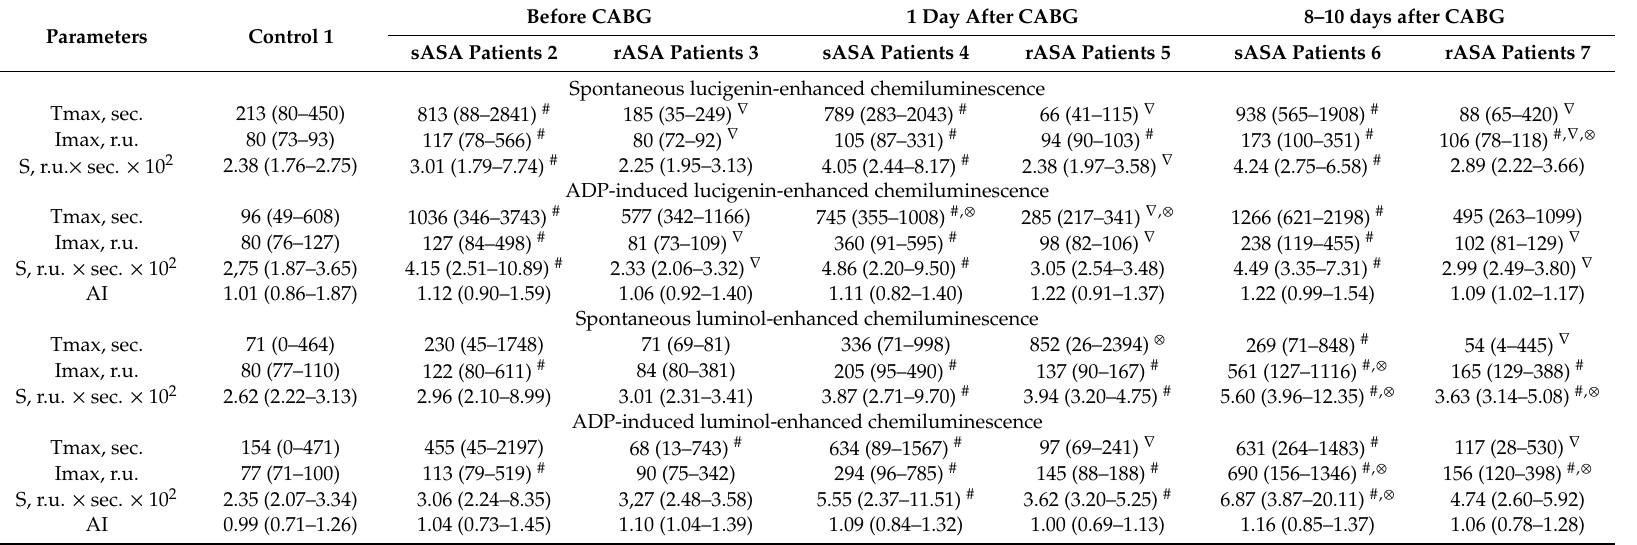
Table 1. Chemiluminescent activity of platelet in patients with CHD before and after